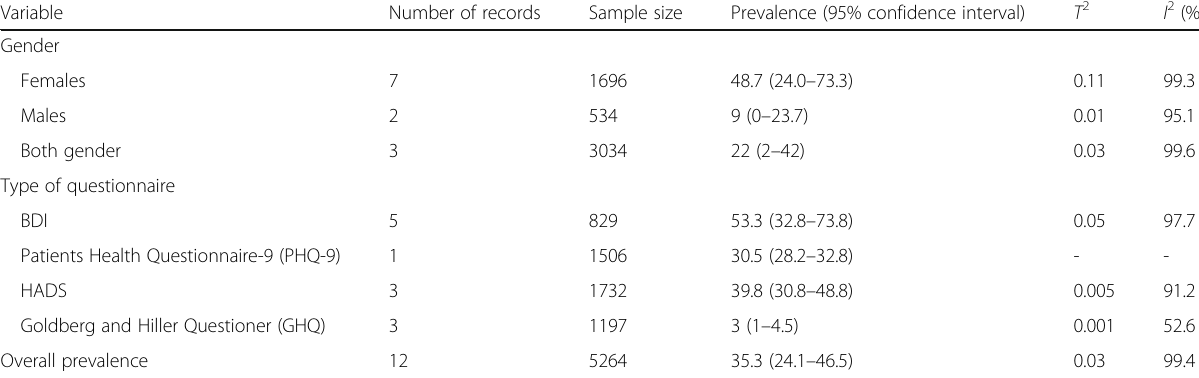
Table 2 The pooled and subgroup depression prevalence among Iranian couples Variable Number of records Sample